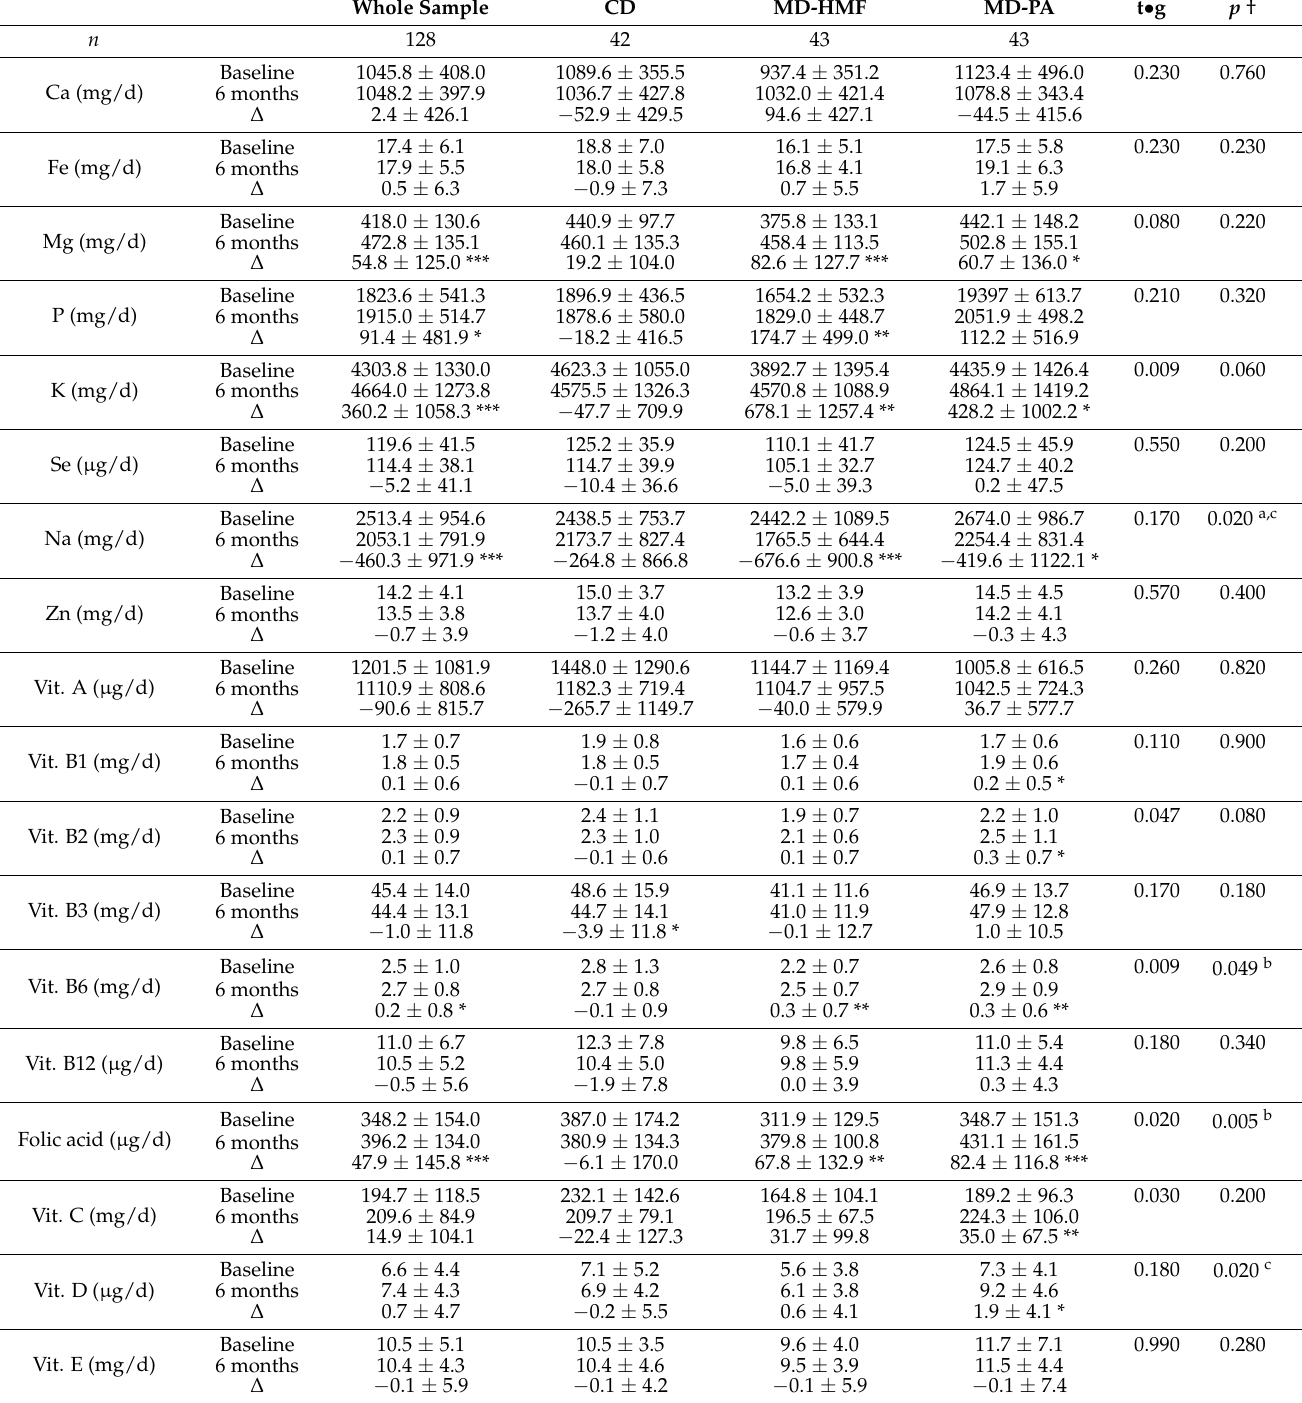
Table 5. Changes in mineral and vitamin intakes within and between intervention groups at 6 months versus